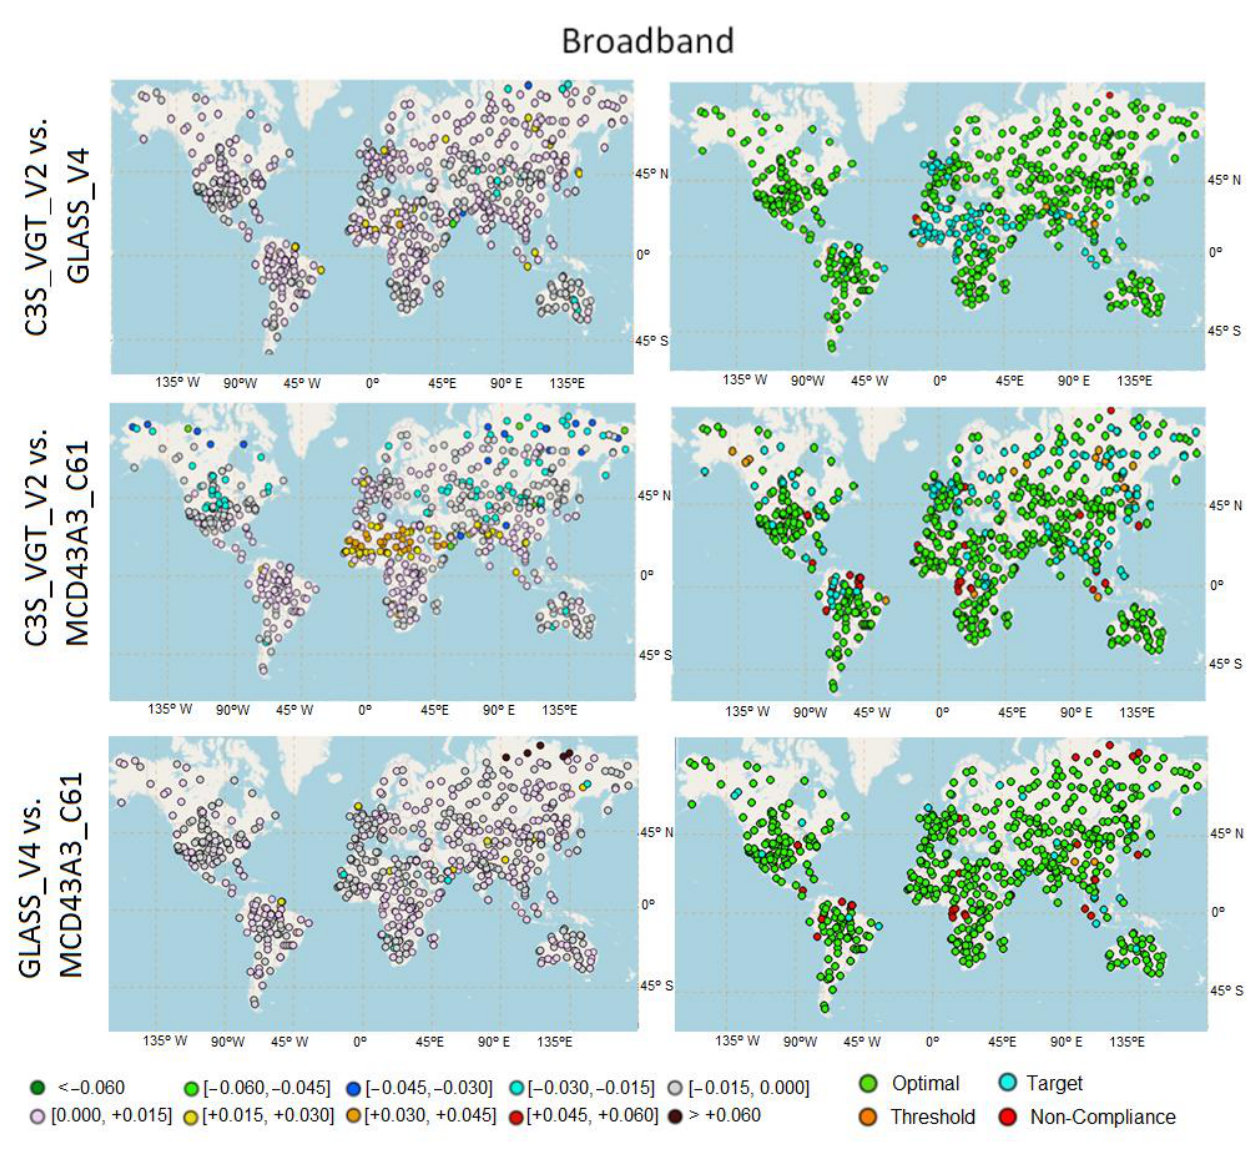
Figure 7. Global spatial distribution of average residuals ( left ) and number of residuals that reach the requirements ( right ) for C3S V2 vs. GLASS V4 ( top ), C3SV2 vs. MCD43A3 C6.1 ( middle ), and GLASS V4 vs. MCD43A3 C6.1 ( bottom ). Evaluation in the 2001–2005 period with a 10-day temporal frequency over LANDVAL sites using best quality total shortwave black-sky albedo (AL-DH-BB) retrievals. Table 7. Percentage of mean residuals between pair of products (C3S V2, GLASS V4 and MCD43A3 C6.1) within each level of uncertainty requirements. Evaluation in the 2001 – 2005 period over